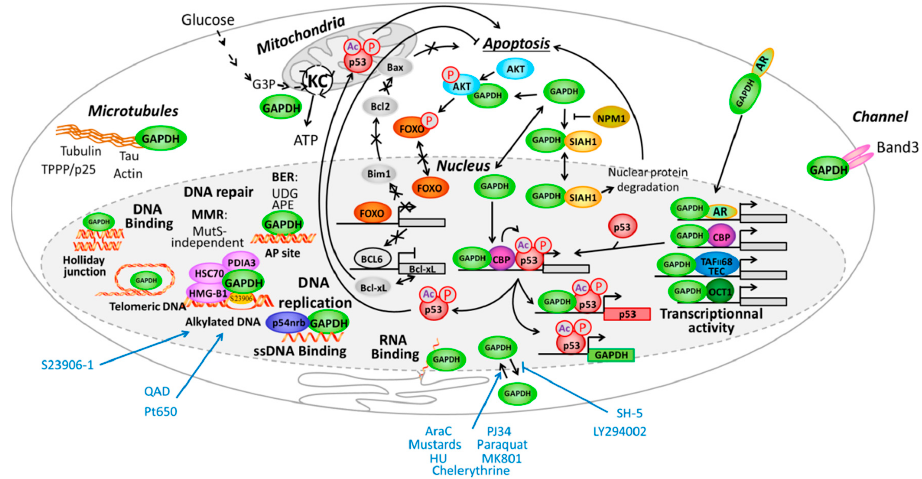
Figure 4. Illustration of some of the multiple functions of glyceraldehyde-3-phosphate dehydrogenase (GAPDH) presented in this